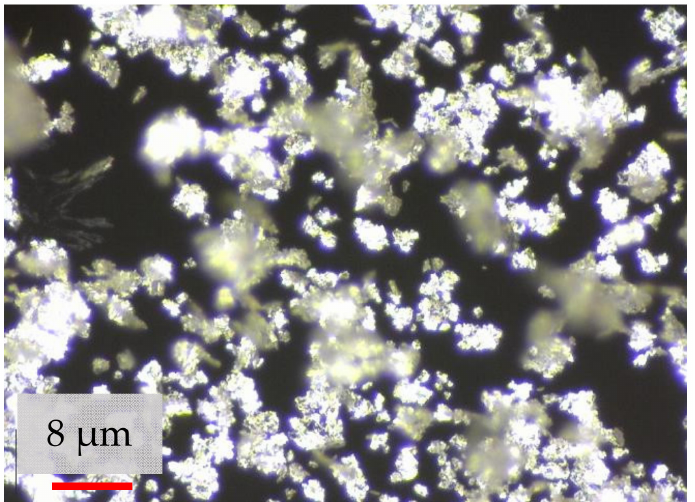
Figure 1. Image of silver nanoflake